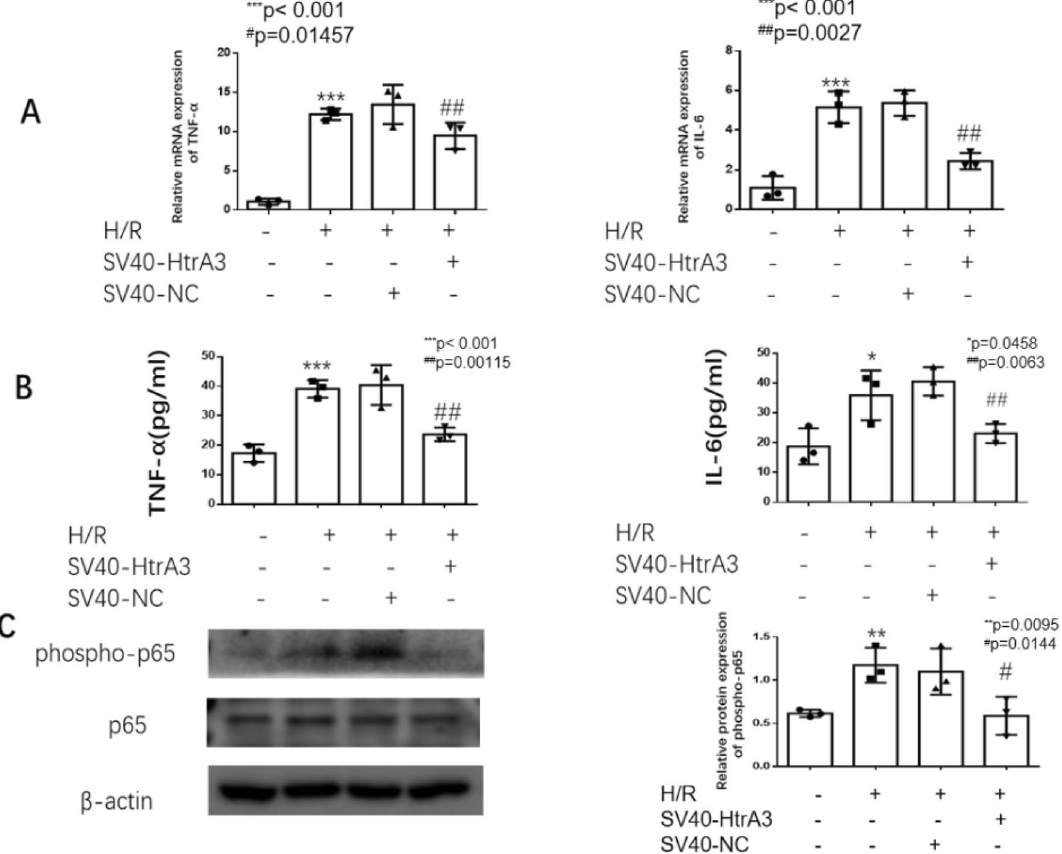
Figure 7. Overexpression of HtrA3 reduced ischemia/reperfusion-induced inflammatory response in HK2 cells. ( A ) Real-time PCR data show overexpression of HtrA3 decreased ischemia/reperfusion-induced mRNA of TNF-α and IL-6; ( B ) ELISA data show overexpression of HtrA3 decreased ischemia/reperfusion-induced TNF-α and IL-6 protein level; ( C ) Western blot data show overexpression of HtrA3 decreased ischemia/reperfusion- induced NF-κB phosphorylation. N (the replicate for above experiments) = 3. *P < 0.05, **P < 0.01, ***P < 0.001, versus control. # P < 0.05, ## P < 0.01, ### P < 0.001, versus hypoxia/reoxygenation treatment